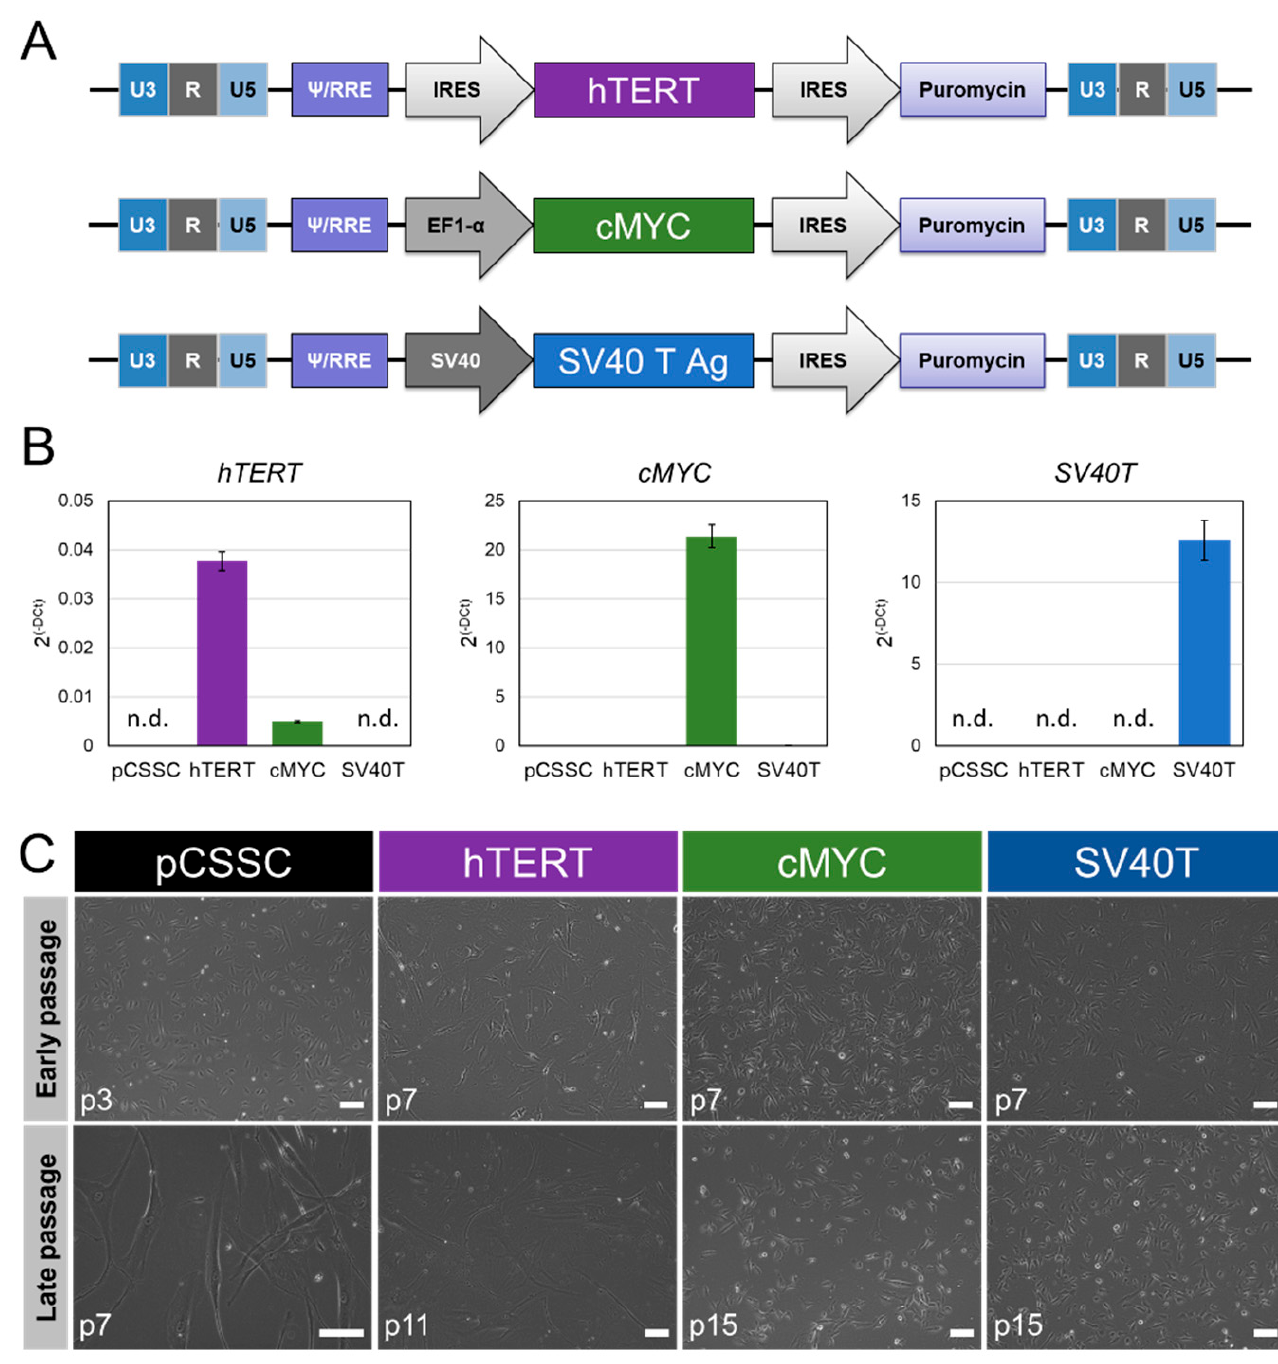
Figure 1. Generation of immortalized CSSC lines. ( A ) Schematic representation of lentiviral constructs for hTERT, c-MYC, and SV40T immortalizing methods. ( B ) Levels of transcript of the immortalization genes (hTERT (p7), c-MYC (p15), and SV40T (p15)) in each cell line, measured by RT-PCR. Results were expressed as mean ± SD. Statistical analysis: ANOVA comparison of the means, followed by all-pair comparisons Tukey’s test. CSSC: corneal stromal stem cells, pCSSC: primary CSSC; n.d.: not detected; p: passage number. ( C ) Phase-contrast images of pCSSC (p3 and p7), hTERT-imCSSC (p7 and p11), c-MYC-imCSSC (p7 and p15), and SV40T-imCSSC (p7 and p15) cells at early and late passages. Scale bar: 100 µ m. CSSC: corneal stromal stem cell; pCSSC: primary CSSC; imCSSC: immortalized CSSC; p: passage number; SD: standard deviation.